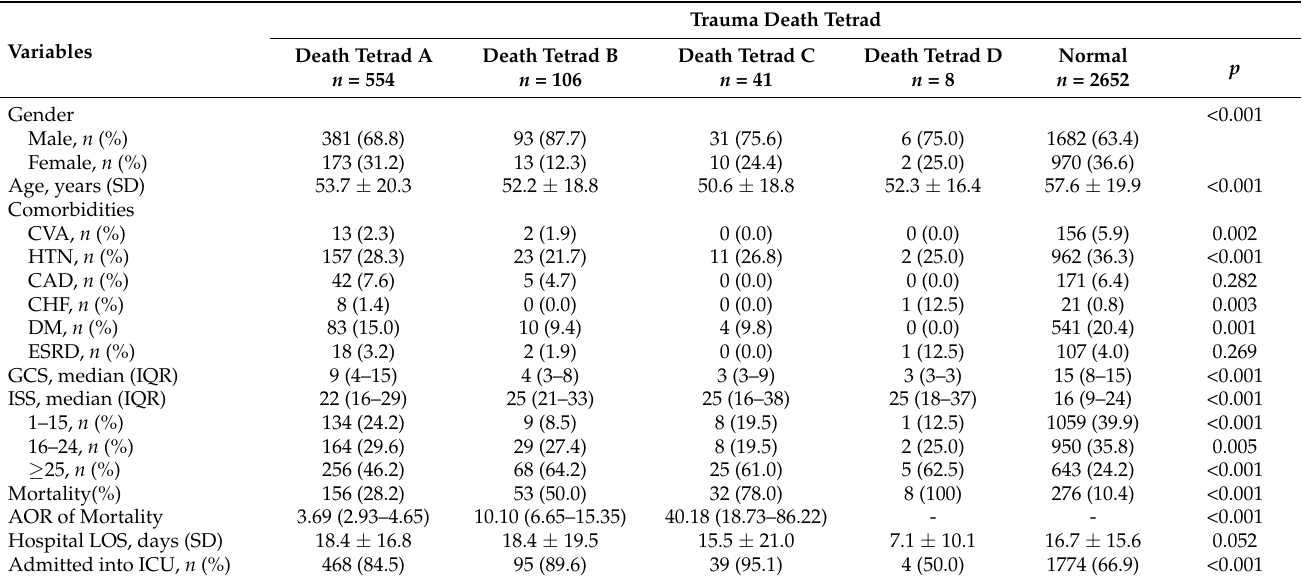
Table 5. The trauma patients grouped according to the number fit in the components of death tetrad. The patients with one, two, three, four items that fit in the components of the death tetrad were allocated into the group of death tetrad A, B, C, D,